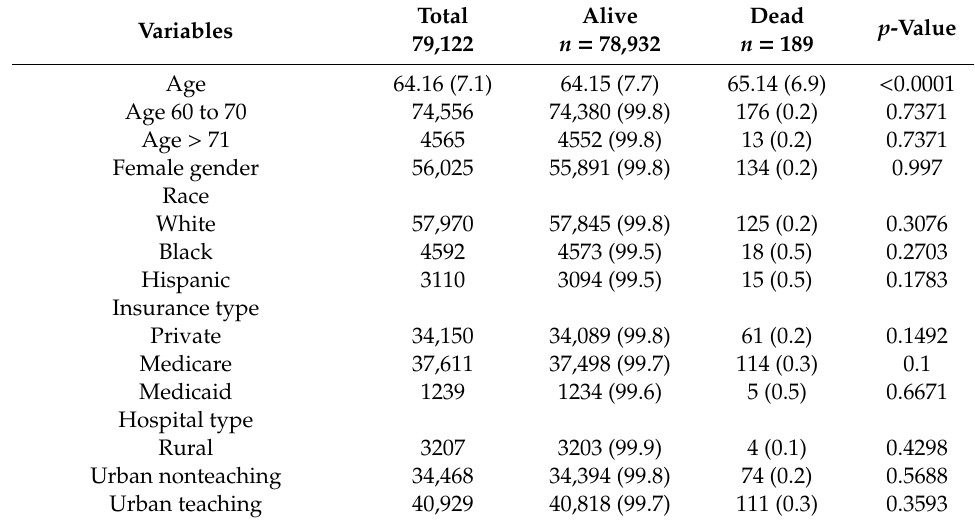
Table 2. Comparison of survivors and nonsurvivors among patients undergoing bariatric